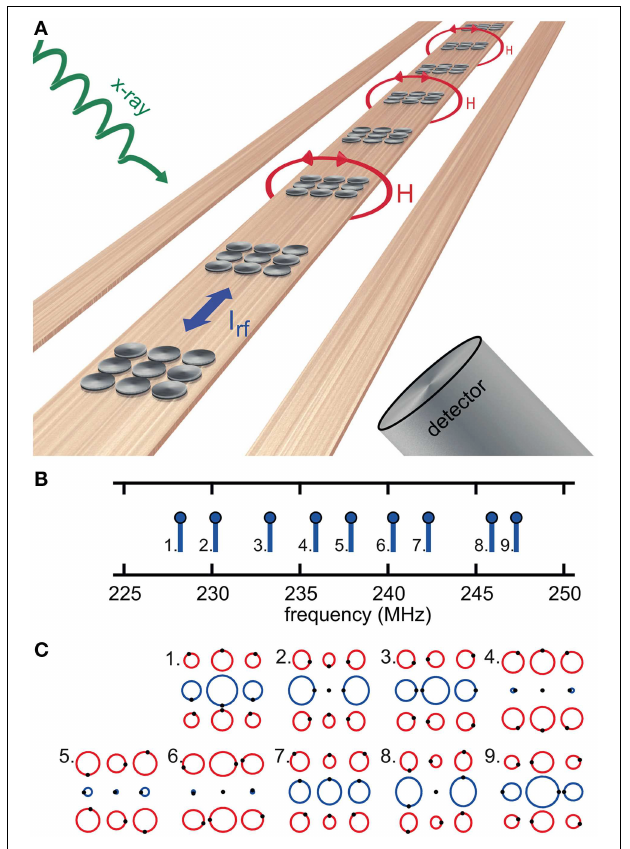
FIGURE 7 | (A) Calculated absorption profiles of the magnonic vortex crystal for all possible polarization patterns. The patterns with lines of constant polarizations are highlighted in red and blue. (B) Experimental results for the self-organized state formation. Starting from a random configuration, ordered polarization patterns are tuned by an adiabatic reduction of a high-frequency magnetic field. The obtained patterns depend on the frequency of